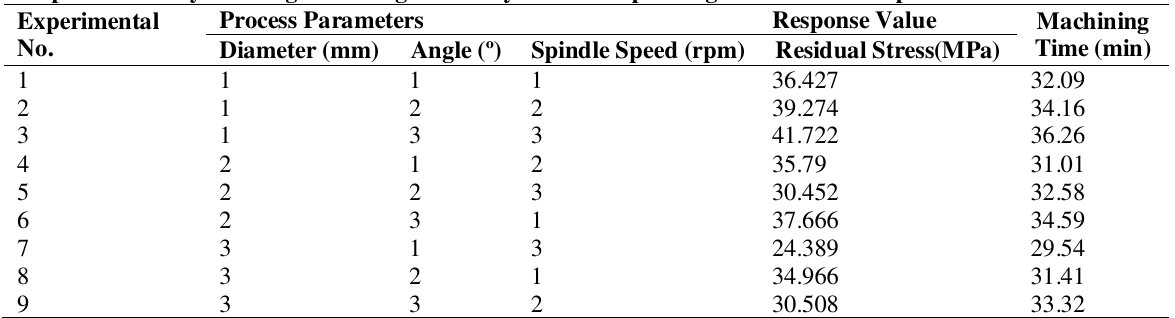
Experimental layout using L9 orthogonal array and corresponding results for hemispherical tool